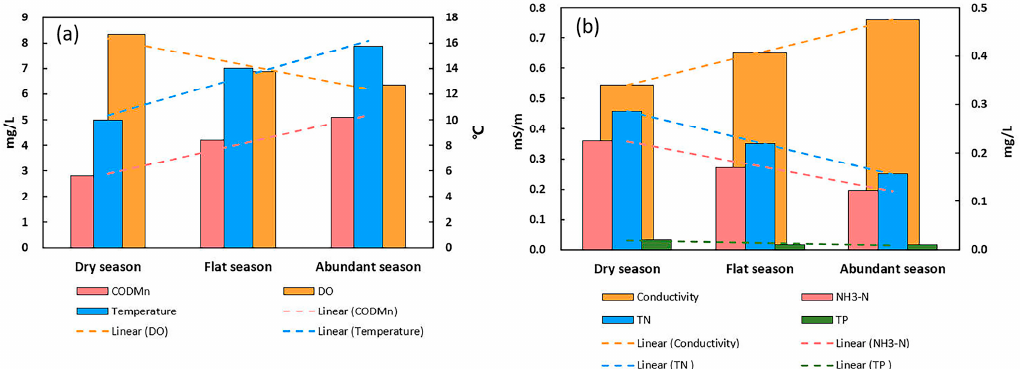
Figure 5. Analysis on annual variation of water quality of typical wetlands in the source region of the Yangtze River. ( a ) changes in COD Mn , DO, and temperature of typical wetlands during the year; ( b ) changes in ammonia nitrogen, TN, TP, and conductivity of typical wetlands during the year.